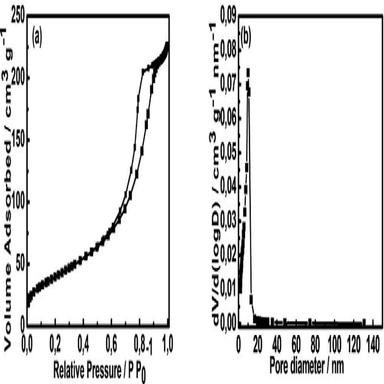
(a) Nitrogen adsorption-desorption isotherm and (b) pore size distribution curve of ZnS/Ni3S2.